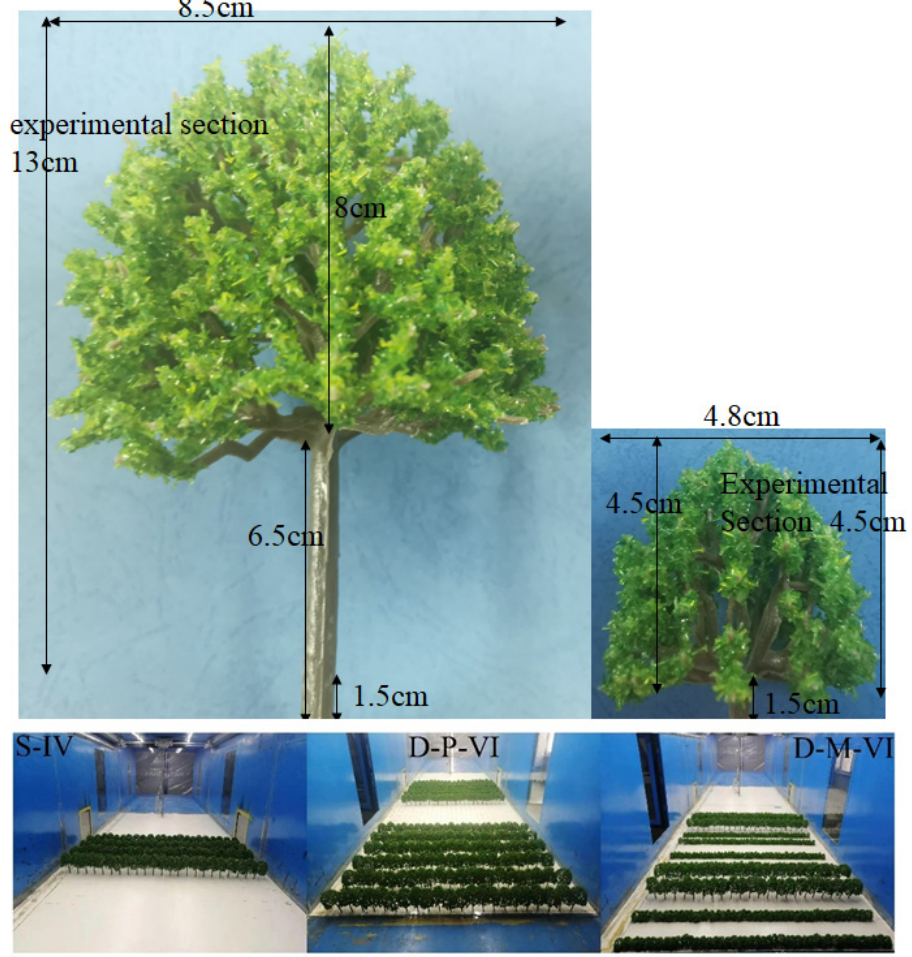
Figure 3. Shelterbelt configurations (1.5 cm at the bottom of the trunk for fixing).